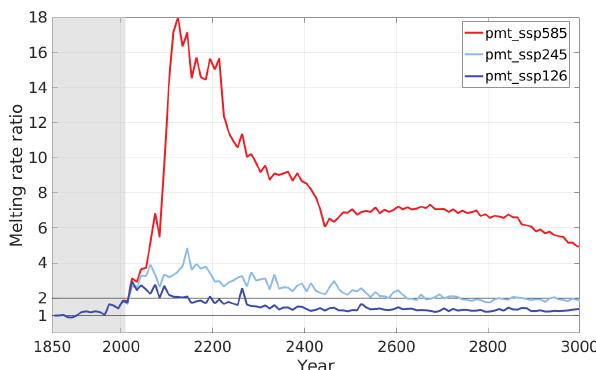
Figure 4. Melting rate ratios relative to pmt_pre for the main scenarios. The 10-year averages. Grey shading marks the historical